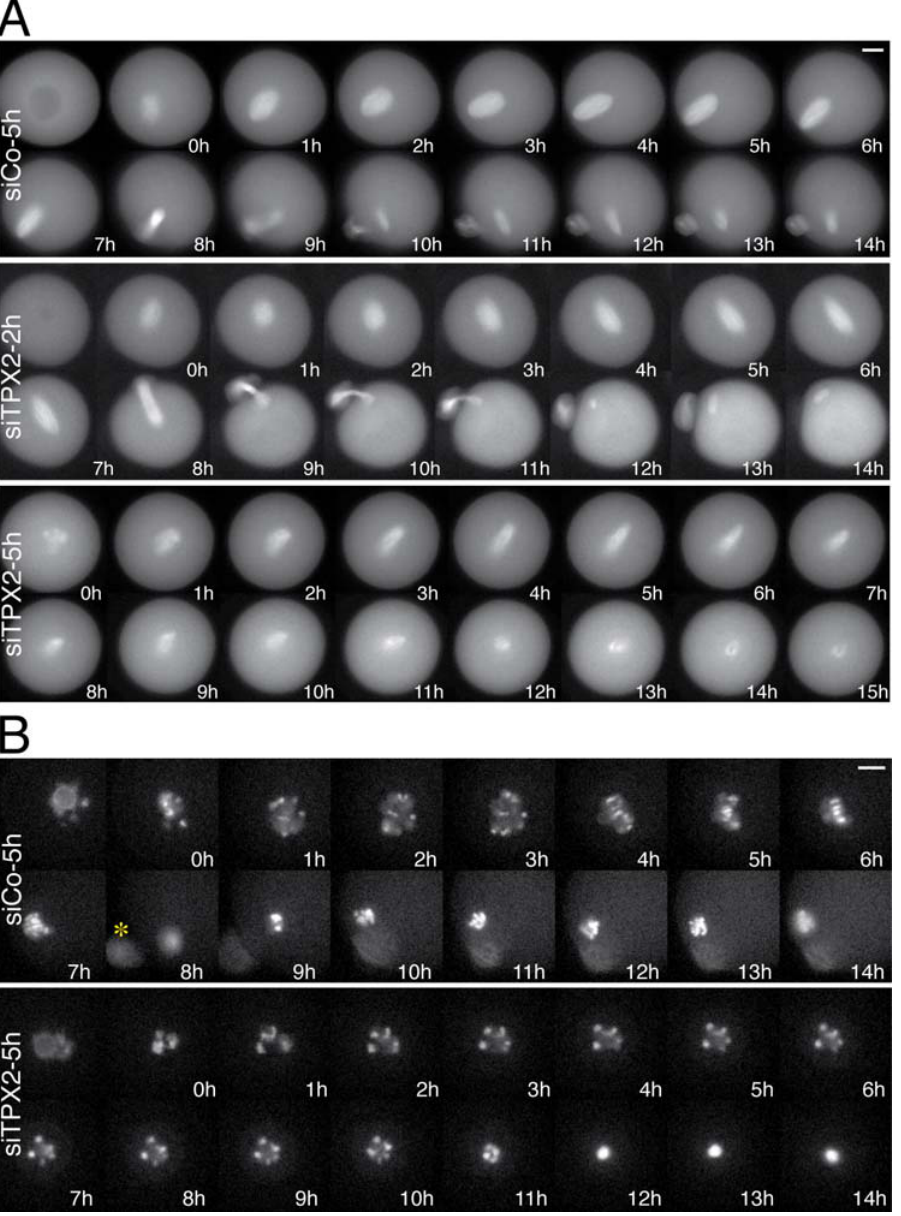
Figure 4. Microtubules and chromosomes behaviour upon TPX2 depletion. A: Representative sequence of fluorescent images showing the microtubule organization in siCo-5h (top panel), siTPX2-2h (middle panel) and siTPX2-5h (bottom panel) injected oocytes expressing a GFP-tagged b - tubulin. Both siCo-5h and siTPX2-2h injected oocytes extruded the polar bodies. However, siTPX2-2h injected oocyte formed small spindle after the polar body extrusion (see panel 12 h). The siTPX2-5h depletion blocked polar body extrusion and the bipolar spindle formed started to collapse three to five hours after GVBD (panels 5 h–15 h). Times are relative to GVBD. B: Representative sequence of fluorescent images showing the morphology and movement of the chromosomes in siCo-5h (upper panel) or siTPX2-5h (bottom panel) injected oocytes expressing RFP-histone H2B. While the chromosomes progressively aligned onto the metaphase plate in the siCo-5h injected oocyte (panel 6 h), the chromosomes in the siTPX2-5h injected oocyte appeared to be stationary during the few hours after GVBD (panels 2 h–8 h). Times are relative to